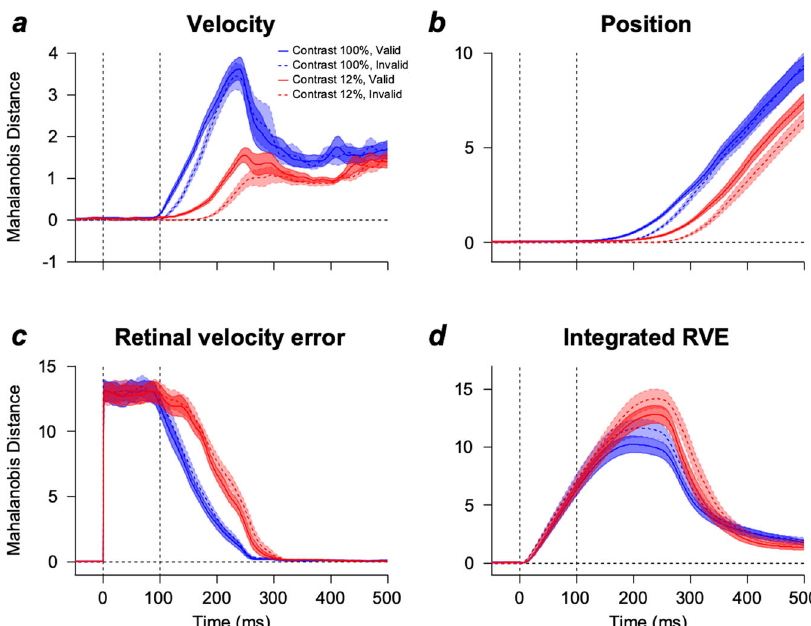
Fig. 5 Pattern dissimilarity across the horizontal and vertical components of the motor and sensory features of eye movements. a – d Pattern dissimilarity (Mahalanobis distance) across the horizontal and vertical components between two motion direction conditions for a eye velocity, b eye position, c retinal velocity error (velocity of sensory motion – eye velocity), and d integral of retinal velocity error. The color-shaded areas indicate the standard errors.